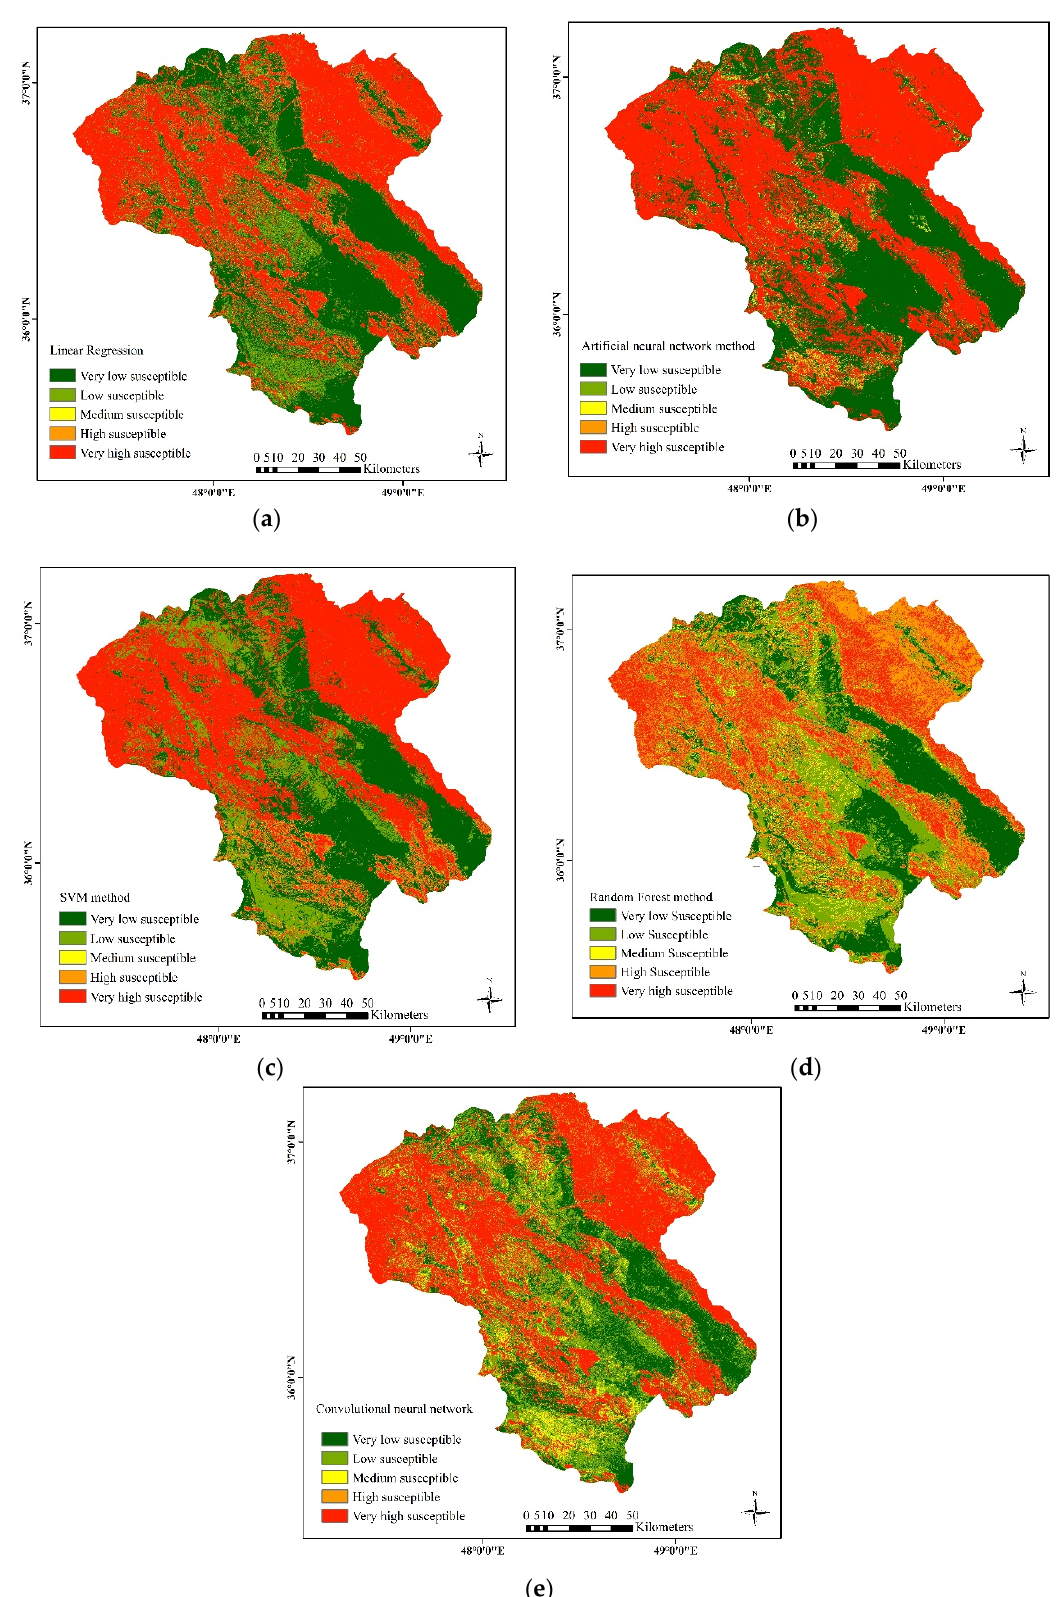
Figure 8. LSMs produced by the five methods in Zanjan province: ( a ) LR, ( b ) ANN, ( c ) SVM, ( d ) RF, and ( e ) CNN.